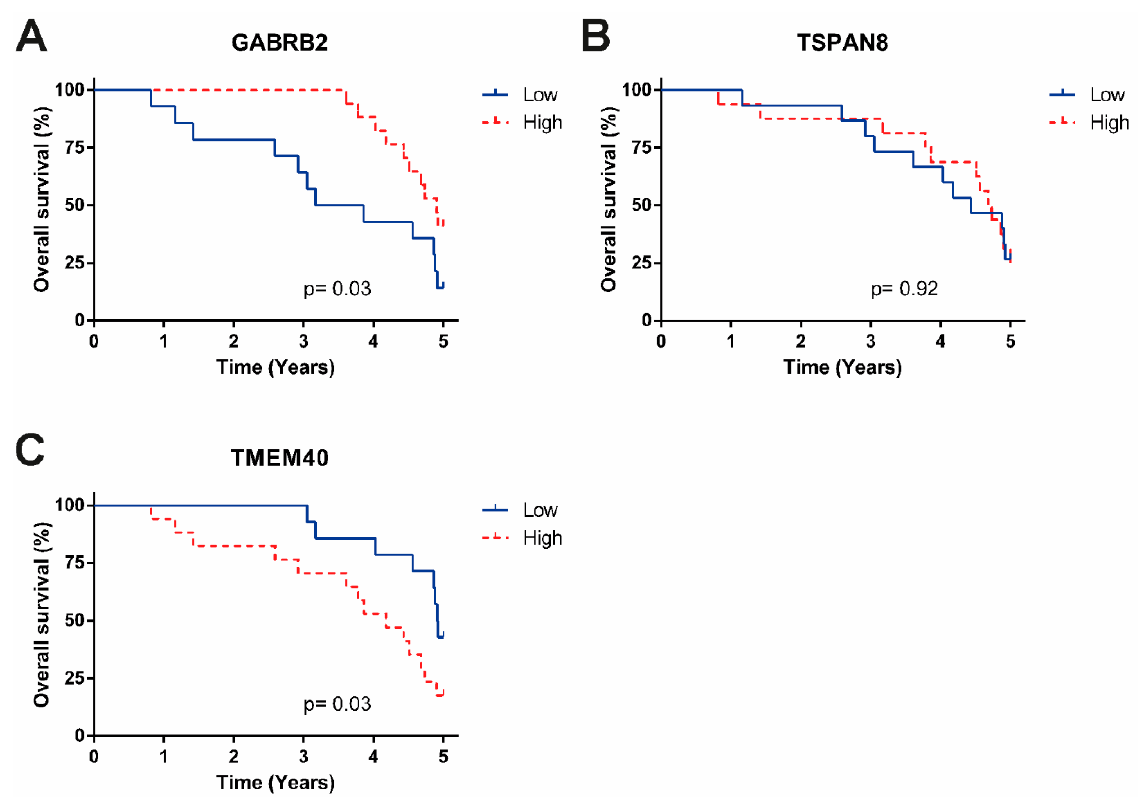
Figure 6. Kaplan-Meier OS analysis of independent Mexican cohort. ( A ) Differences in the OS of